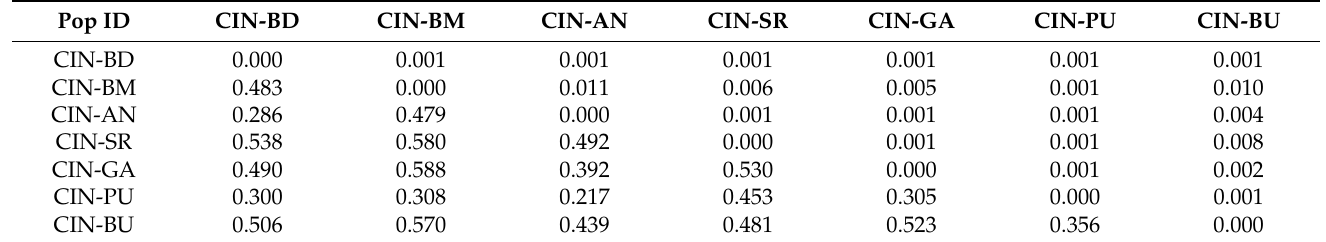
Table 9. Nei’s unbiased measures of genetic identity and distance among the groups of accessions of C. intybus